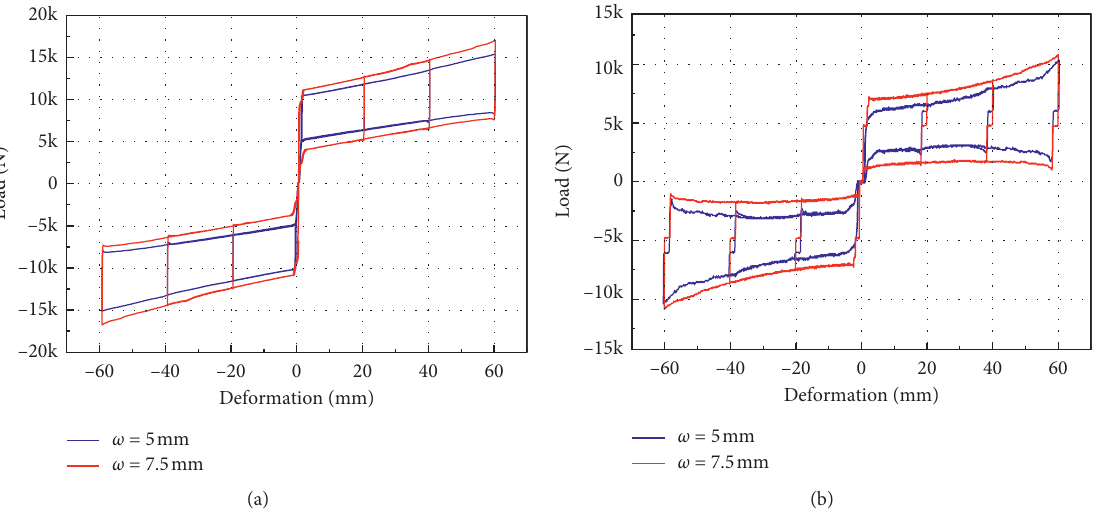
Figure 7: Hysteretic performance under 5 and 7.5mm deflection of the friction plate. (a) Hysteresis curve of SCVF brace with spring S1. (b) Hysteresis curve of SCVF brace with spring S2. Table 7: Mechanical parameters of SCVF brace under 5 and 7.5mm deflection of the friction plate. Spring stiffness K 0 (N/mm) Deflection w (mm) Energy dissipation W d (J) Tension spring S2 28.5 Tension spring S1 55.2